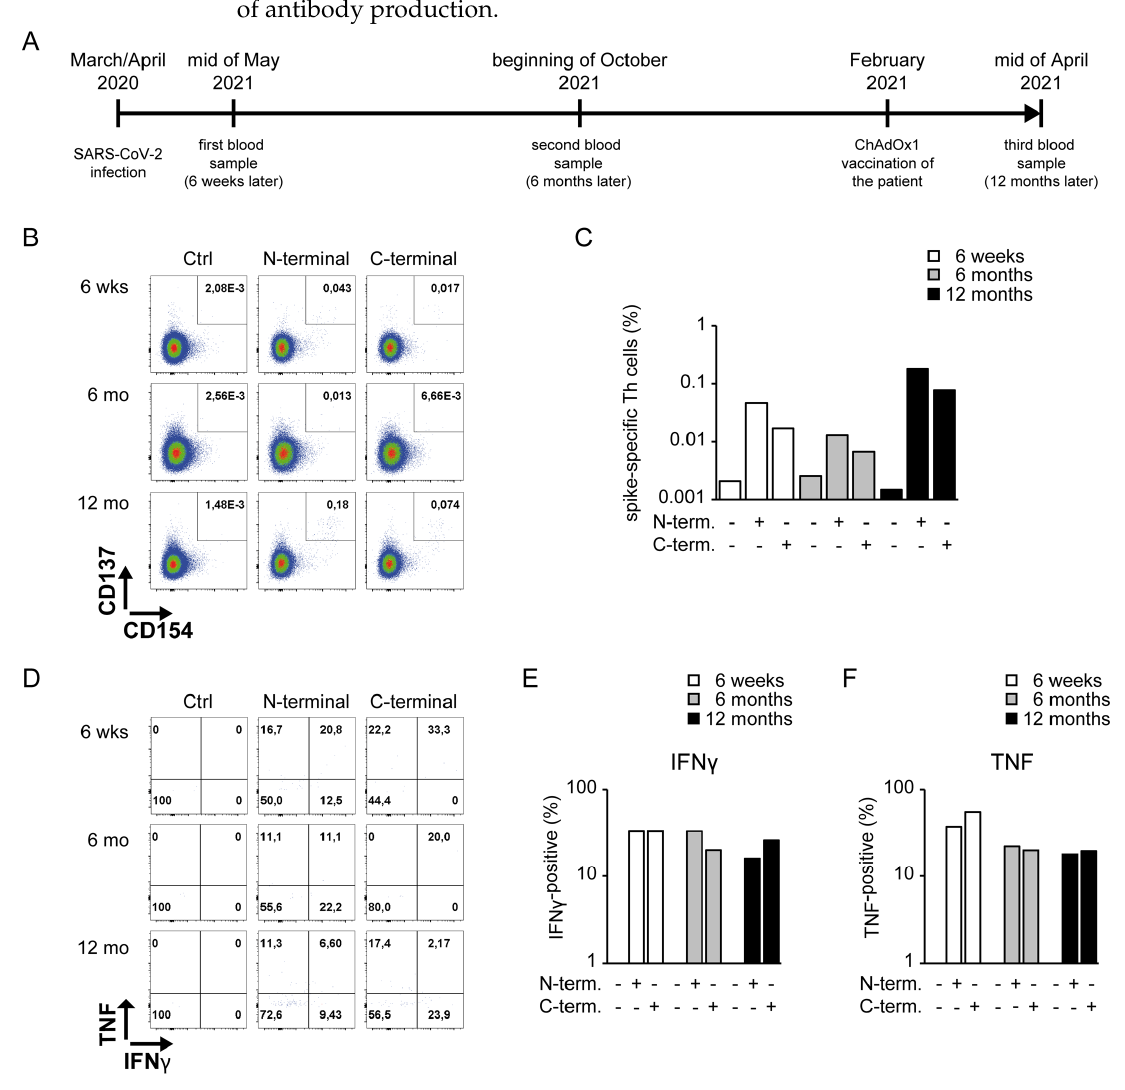
Figure 1. SARS-CoV-2 S protein-specific Th cells in an anti-SARS-CoV-2 antibody-negative patient upon infection and vaccination. Peripheral Blood Mononuclear Cells (PBMCs) collected at several time points were restimulated with peptide mixes covering the SARS-CoV-2 spike protein and cytokine production among SARS-CoV-2-specific Th cells was analyzed. ( A ) Timeline relatively indicates all time points addressed in the case report. ( B ) FACS plots and ( C ) bar plots of antigen- specific CD154 + CD137 + cells among living CD4 + CD3 + Th cells are shown upon indicated restimulation. S-Mix (N) indicates SARS-CoV-2 Spike glycoprotein PepMix 1 (N-terminal coverage), and S-Mix ( C ) indicates SARS-CoV-2 Spike glycoprotein PepMix 2 (C-terminal coverage ) . Presence of a stimulus is indicated with “+” and absence of a stimulus is indicated as “-”. ( D ) FACS plots and ( E , F ) bar plots of IFN γ - ( E ) or TNF- ( F ) producing cells among living antigen-specific CD154 + CD137 + CD4 + CD3 + Th cells are shown upon indicated restimulation. A SARS-CoV-2-specific Th cell response can be detected by restimulating PBMCs with peptides of the spike protein, as described by Braun et al. [12]. By flowcytometry, the per-cell expression of Interferon γ (IFN γ ) and tumor necrosis factor (TNF) among spike- reactive CD137 + CD154 + double-positive CD4 + Th cells was detected (Figure 1B–F). In